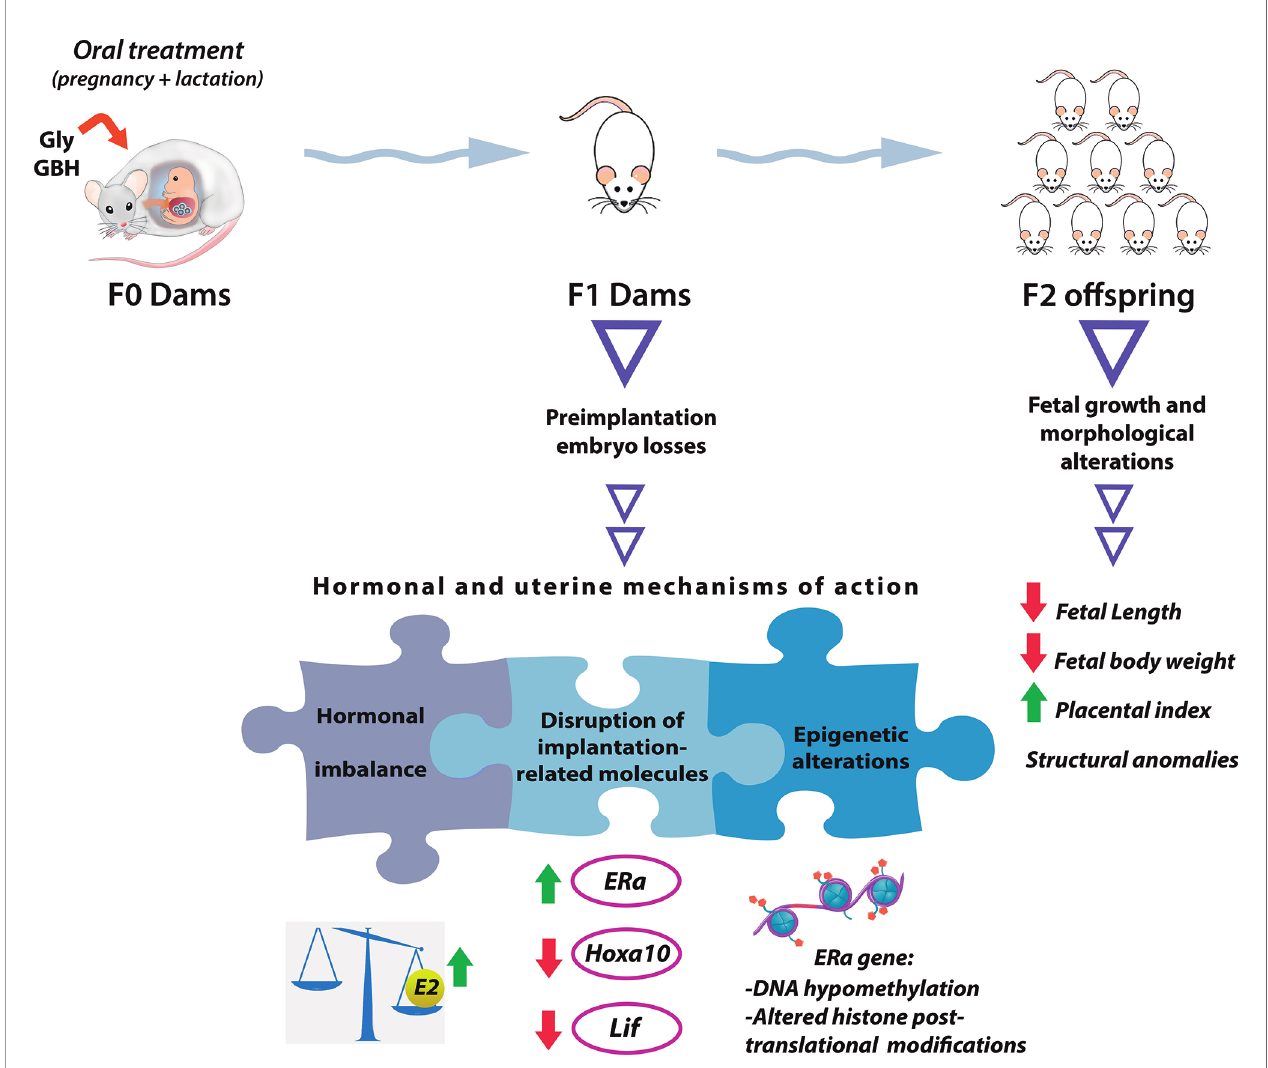
FIGURE 1 | The scheme summarizes the multigenerational effects of the herbicide glyphosate (active ingredient and a glyphosate-based herbicide) on F1 adult female rats and their F2 offspring after perinatal exposure (during gestation and lactation) through food. The color green or red of the arrows denotes induction or inhibition of the molecular targets, respectively. Gly, glyphosate (active ingredient); GBH, glyphosate-based herbicide; E2, 17 b -estradiol; ER a , estrogen receptor alpha; Lif, Leukemia inhibitory factor; Hoxa10, Homeobox